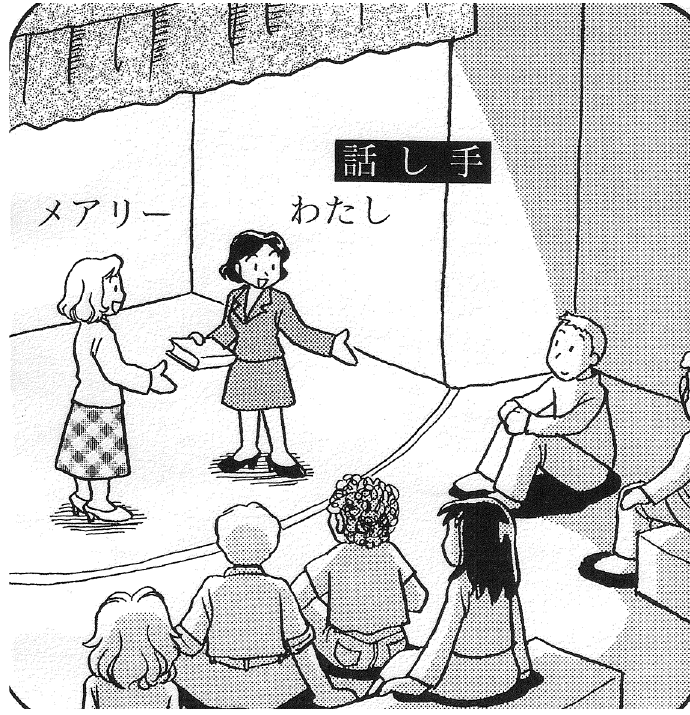
Figure 4. Mary gave (me this book) [Japanese] (Ide 2006: 222). 12